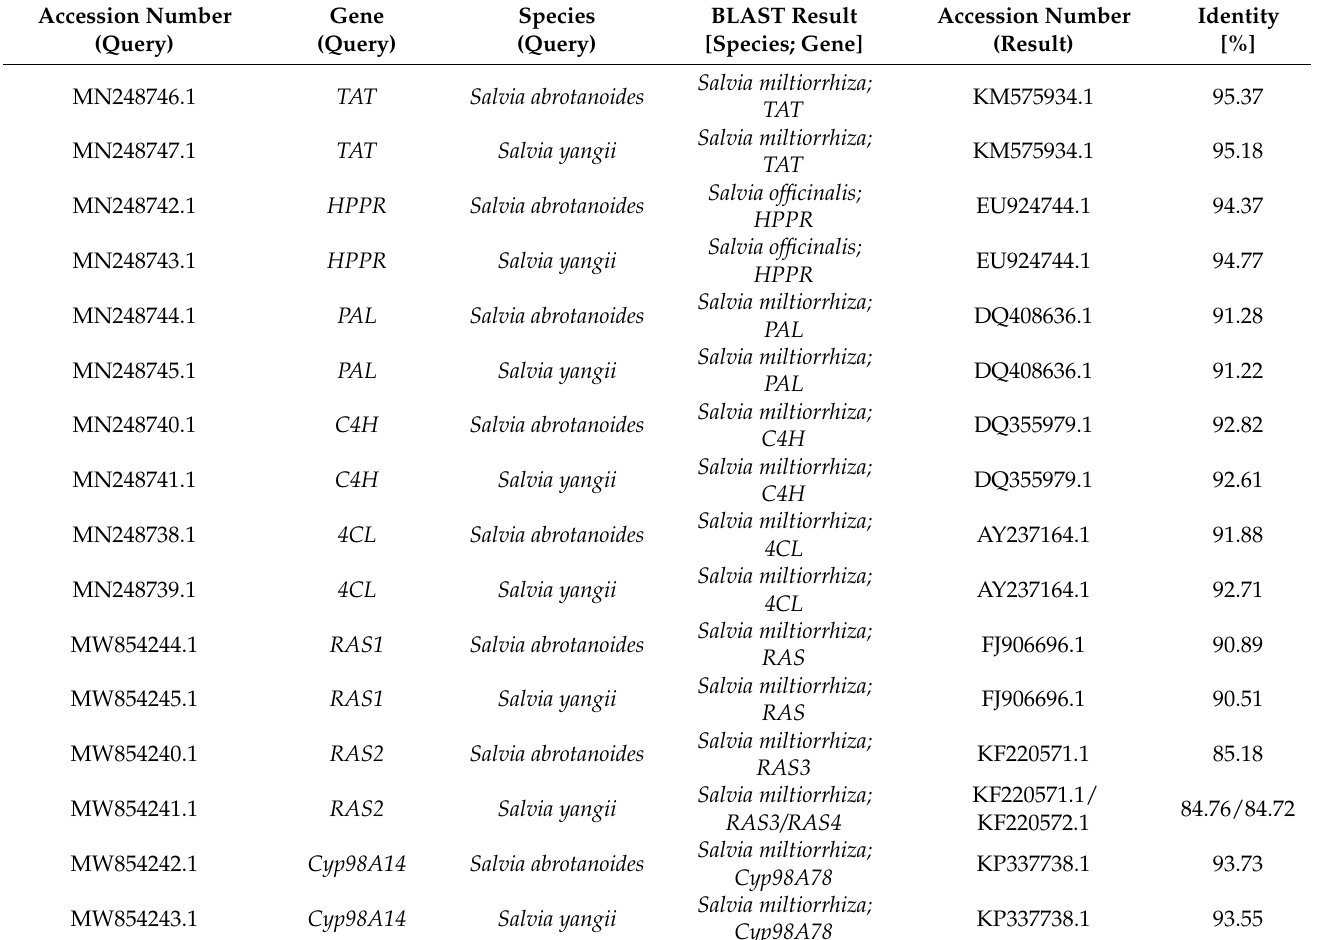
Table 3. Results of the BLAST